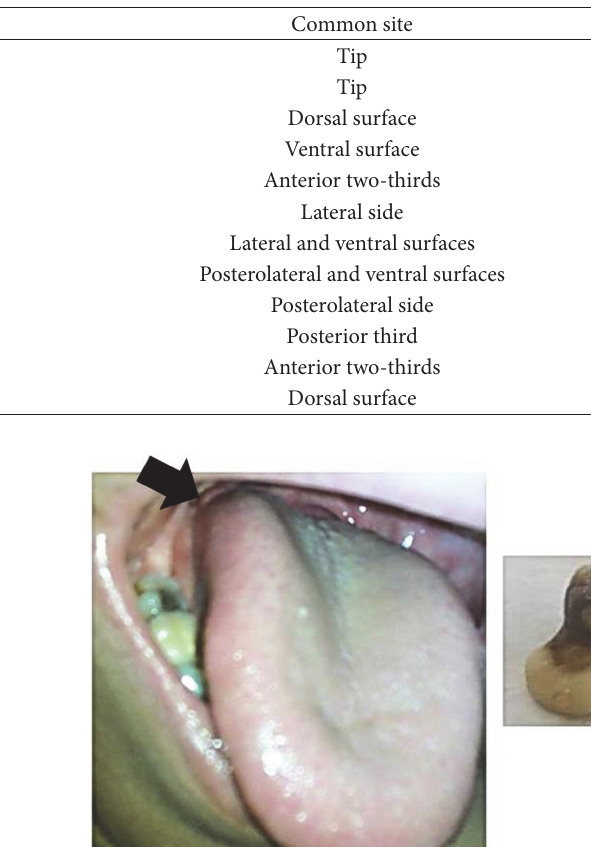
Table 1: Different types of tongue swellings adapted from Neville et al. [5].